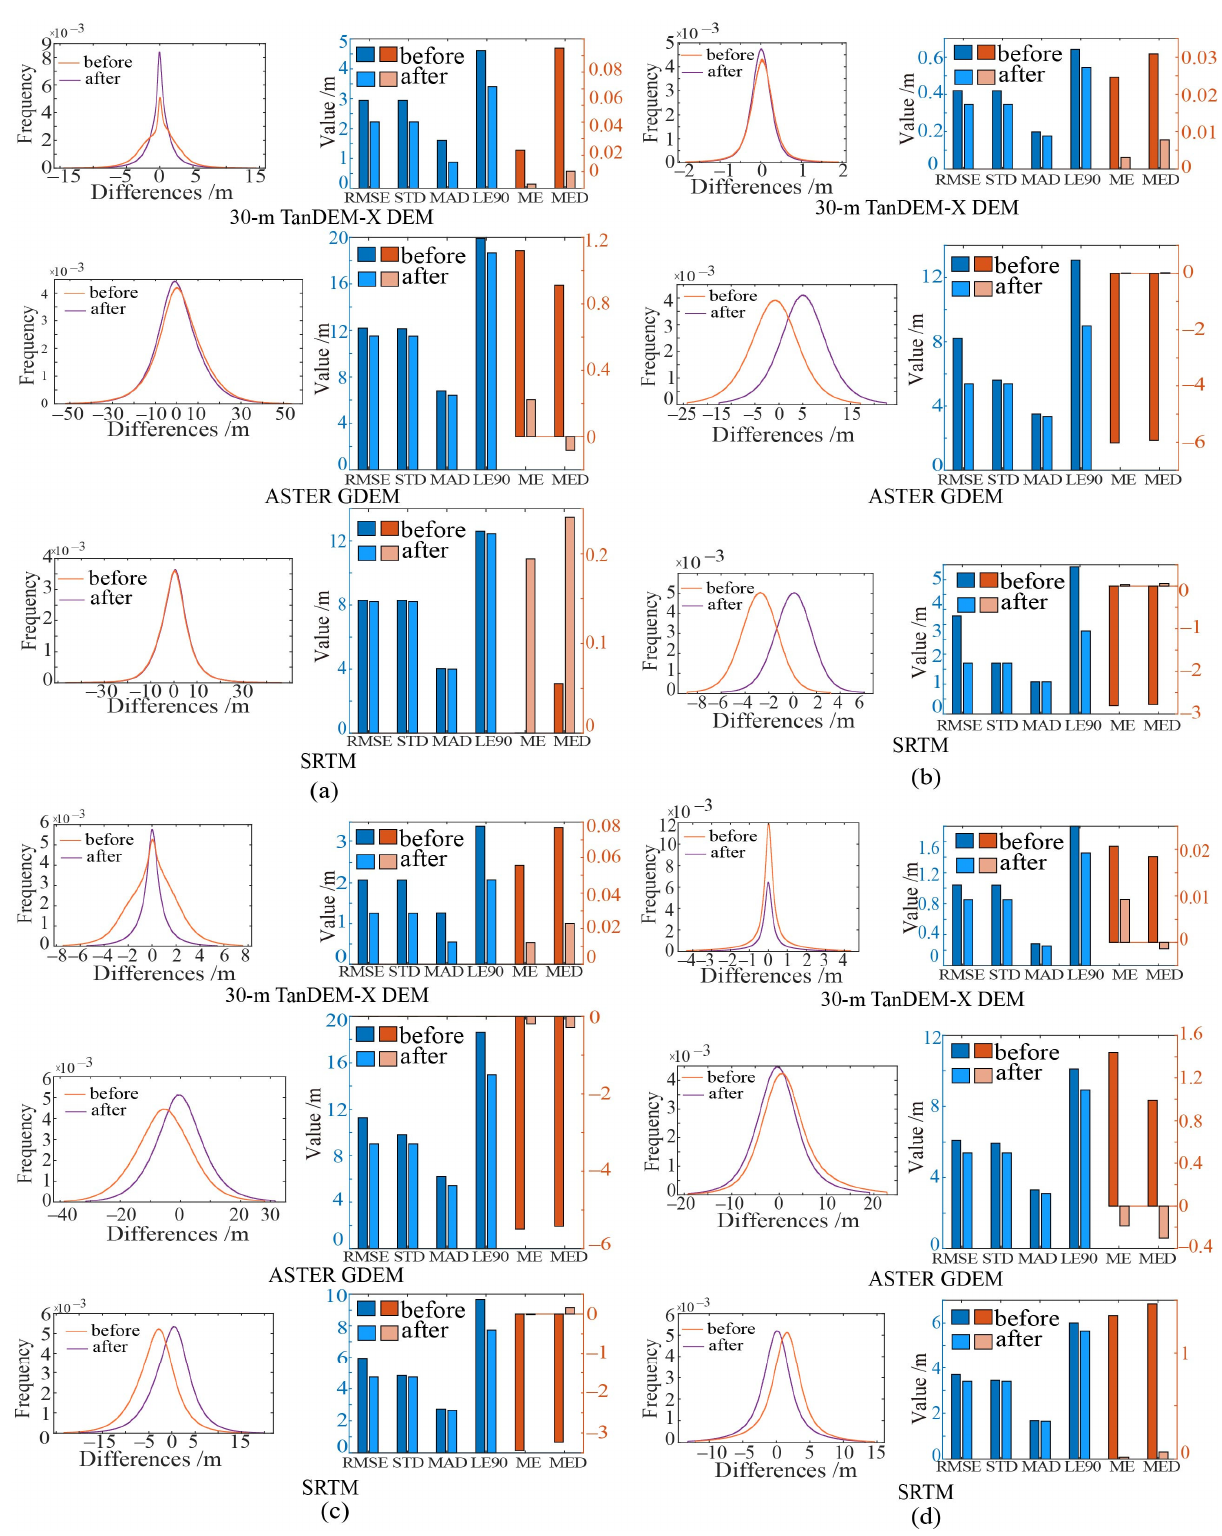
Figure 13. Histograms of the elevation differences between models before and after co-registration, and corresponding bar charts showing statistical indicators in: ( a ) Sichuan; ( b ) Xinjiang A; ( c ) Xinjiang B; and ( d ) Inner Mongolia.